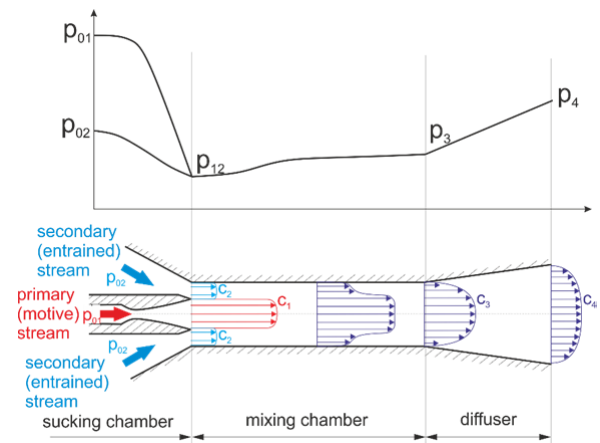
Fig. 1. Static pressure distribution and velocity profile development along a mixing chamber and a diffuser.